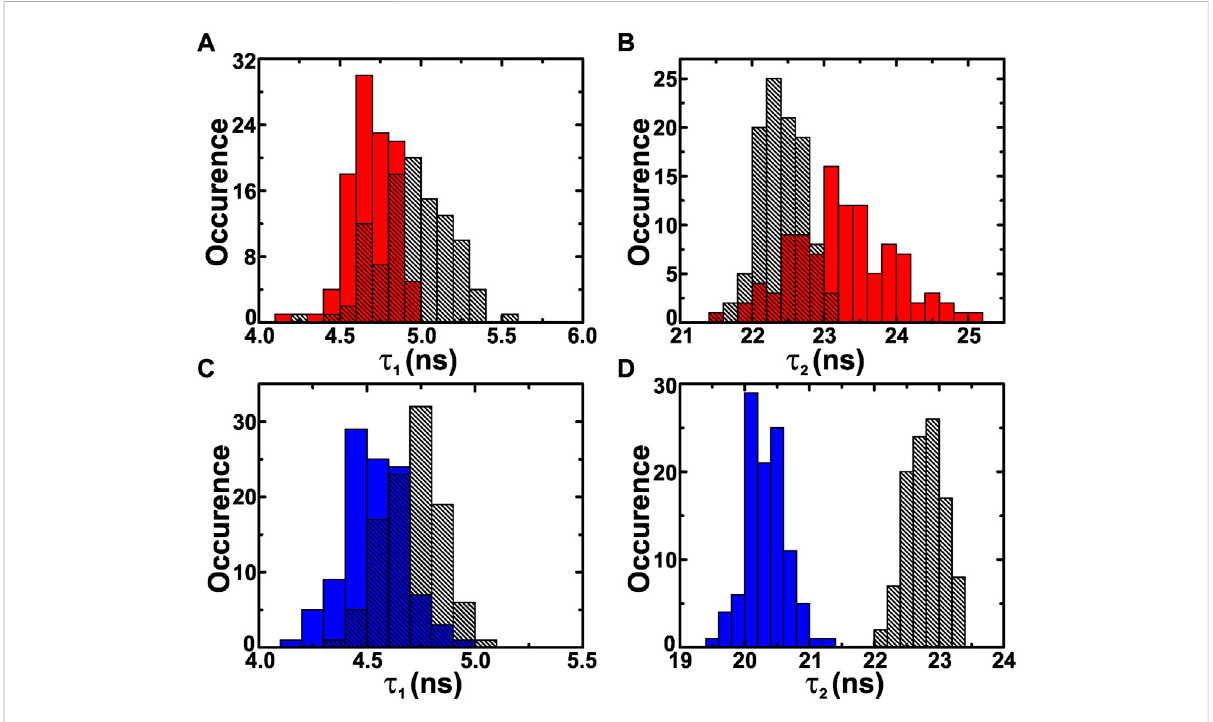
FIGURE 7 τ (A,B) The τ 1 and 2 distributions corresponding to the reference (patterned) and sample B (red) measured at 660 nm in the rear-side geometry. (C,D) The τ τ 1 and 2 distributions of the for the reference (patterned) and sample B measured in the front-side